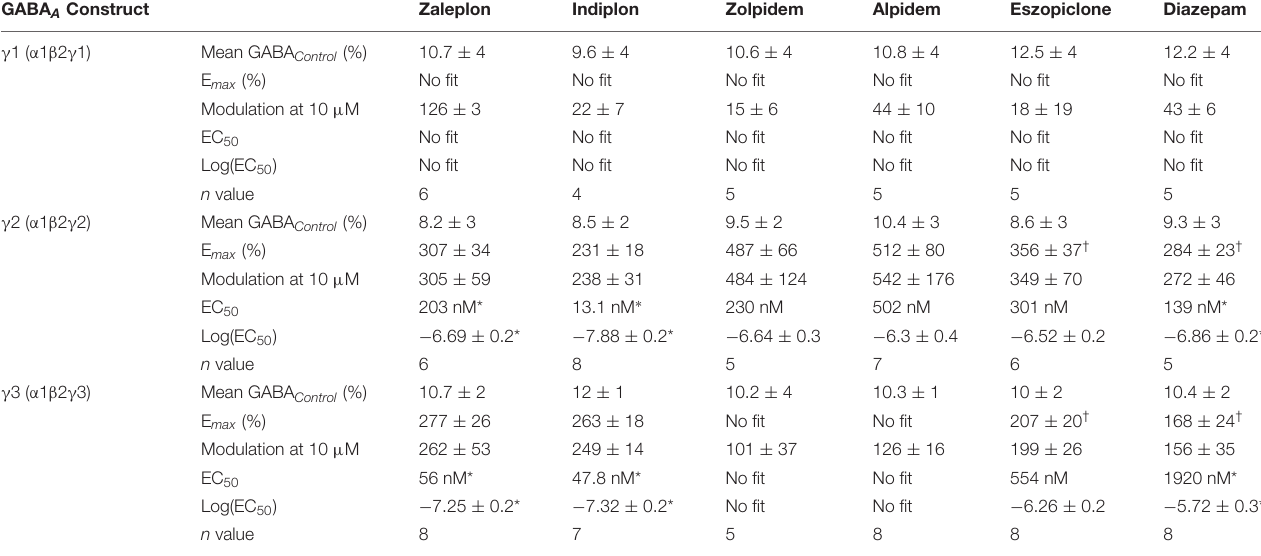
TABLE 1 | Potency and efficacy of Z-drugs on GABA A receptors with varying γ subunits. GABA A Construct